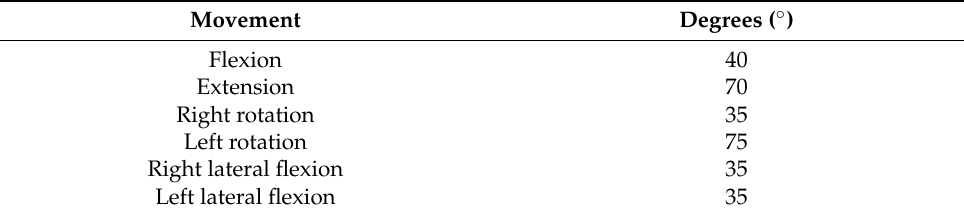
Table 1. Measurement of active ROM (degrees) in a seated position. Movement